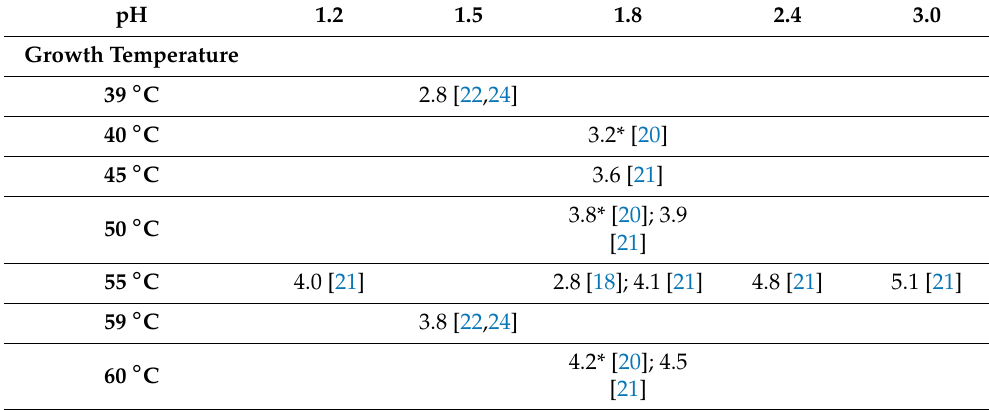
Table 1. Average number of pentacycles in the main glycophospholipid